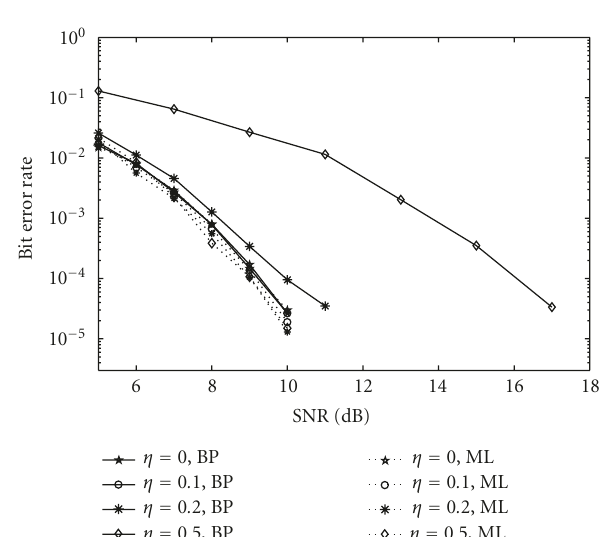
Figure 4: E ff ect of number of iterations.